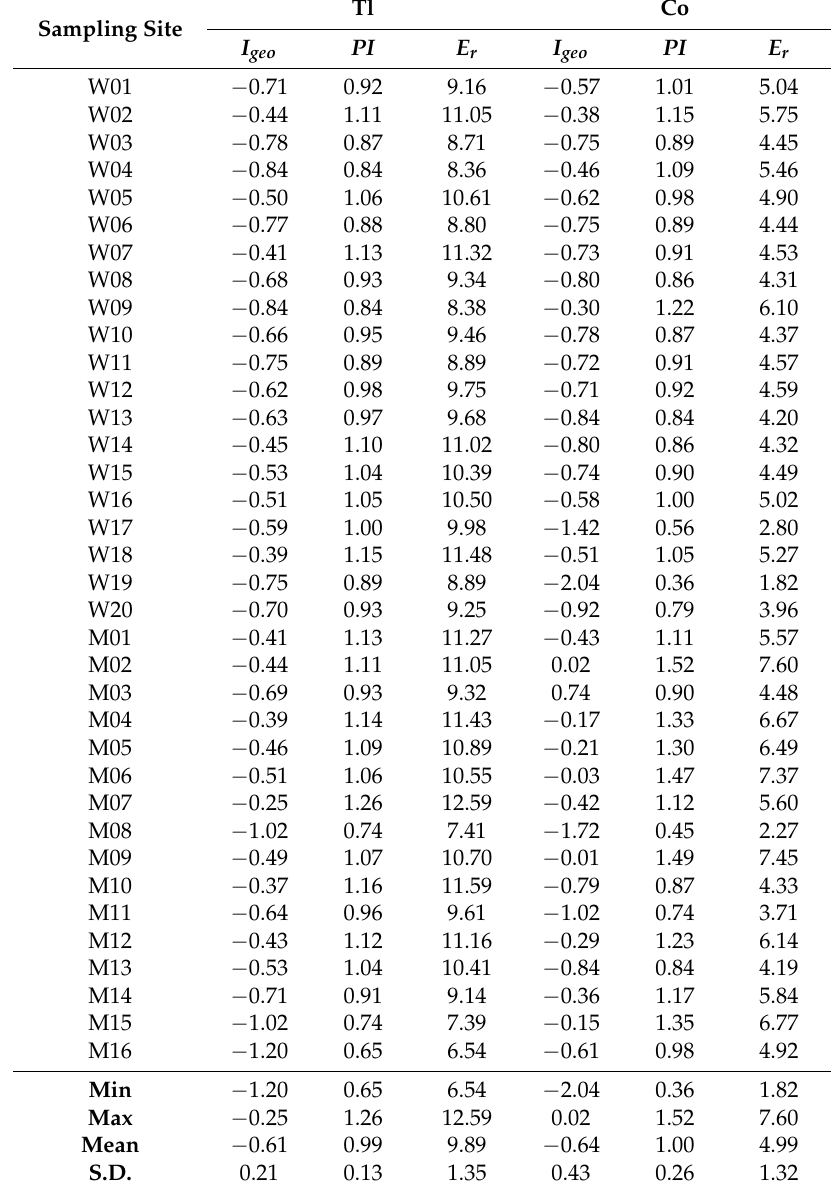
Table 3. Assessment of Tl and Co in surface sediments of Poyang Lake using geochemical baseline concentrations